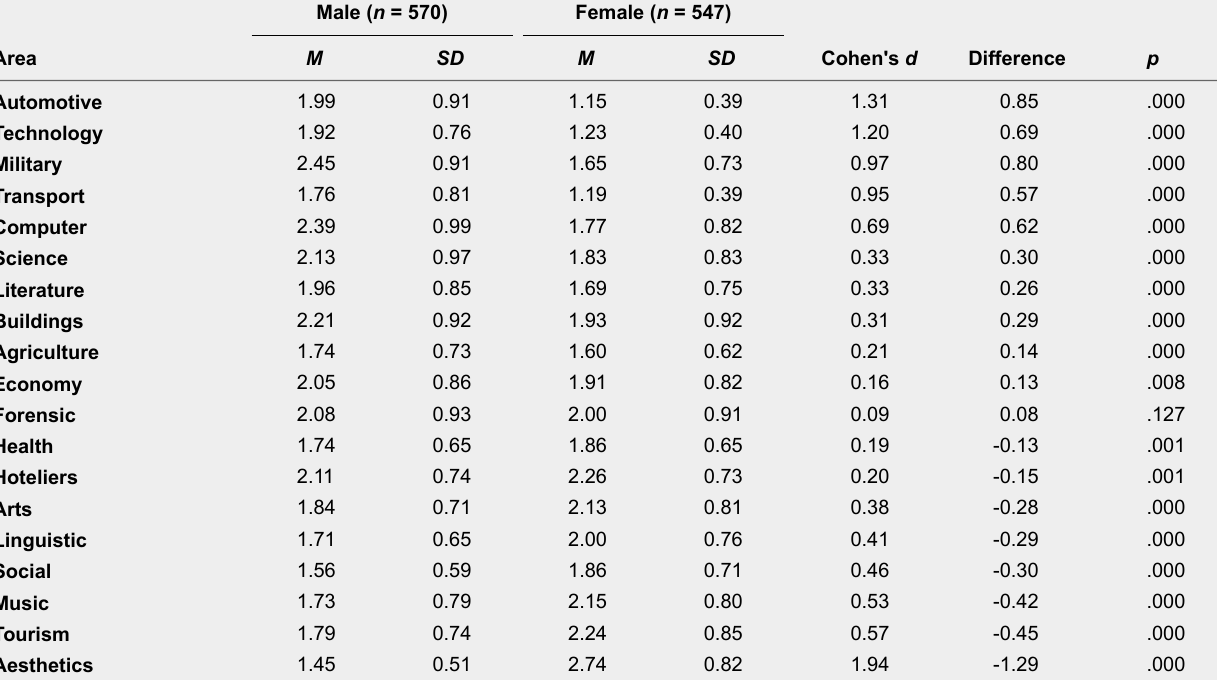
Gender Mean Differences and Effect